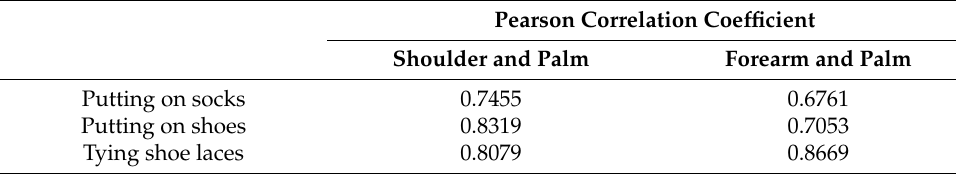
Table 1. Pearson correlation coefficient for arm and palm.